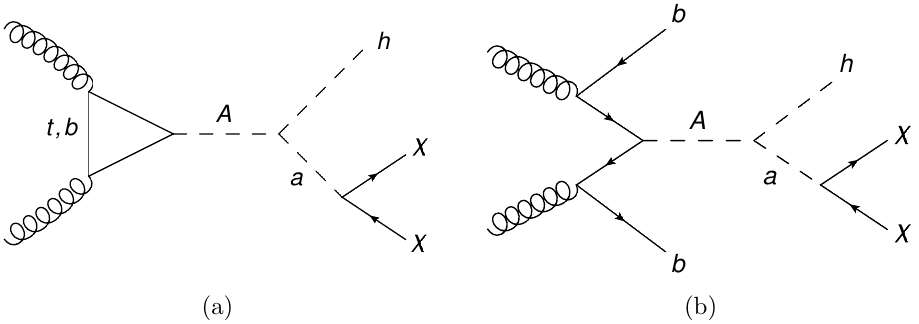
Figure 2. Feynman diagrams for the main production mechanisms of the mono-Higgs signature in the 2HDM+ a scenario: (a) gluon-gluon fusion and (b) b -associated